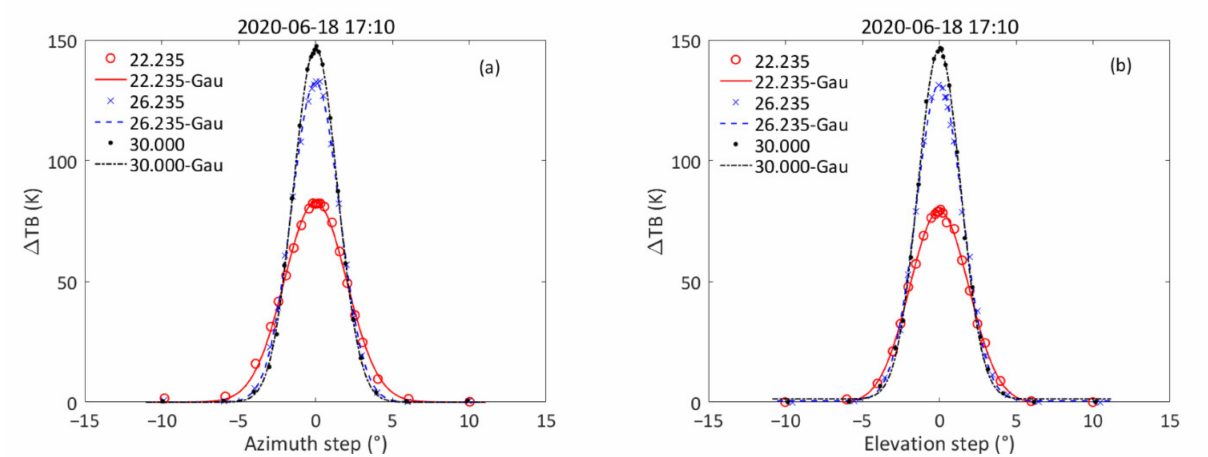
Figure 6. The same as Figure 5 but for 18 June 2020, 17:10 p.m. (local time). The angle distortion was calibrated and the solar elevation was 31.5 ◦ . ( a ) Azimuth scanning, and ( b ) Elevation